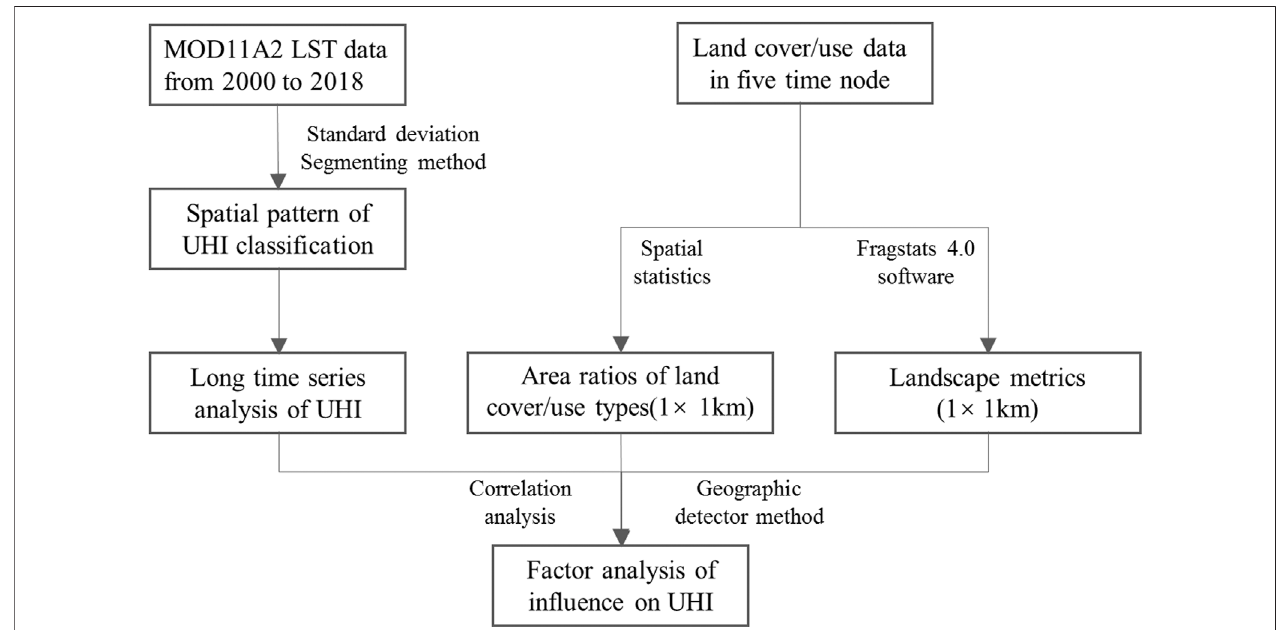
FIGURE 2 | The fl owchart of the study.